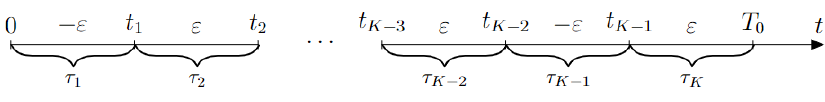
Figure 1. Control intervals for optimal control u ∗ ( t )